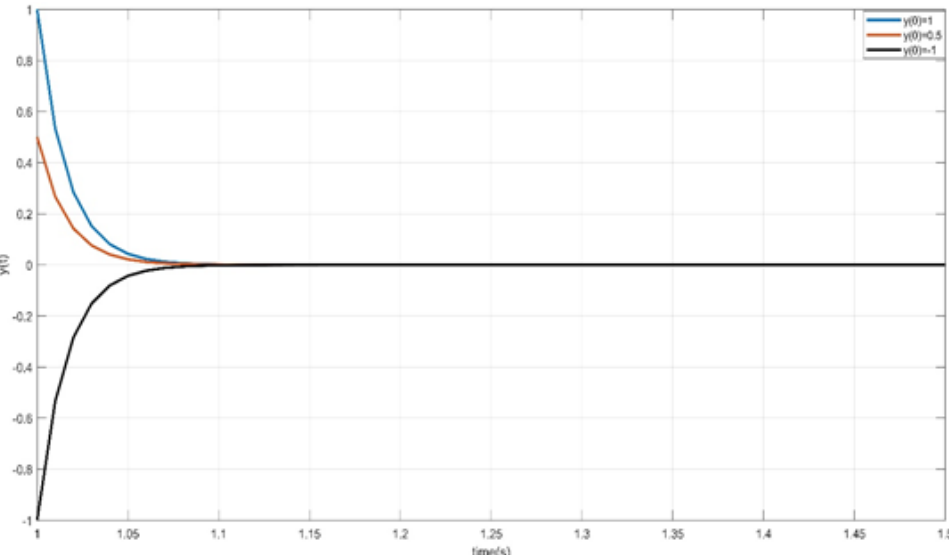
Figure 1. The paths of y ( t ) solutions of continuous and discrete scalar IDDE (13), which verify, in a particular case, the US, UAS and integrability of the solutions for different initial values, y ( 0 ) = − 1, y ( 0 ) = 0.5 and y ( 0 ) =